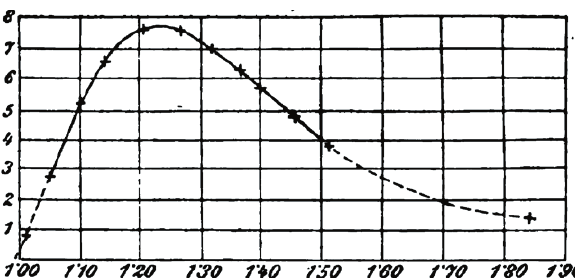
Figure 4. “Relative Leitfähigkeit” (relative conductivity) vs. specific weight (also density) of dilute sulphuric acid. The resistance was measured with alternating current as described in the main text. Abscissa: specific weights of the acid solution at 18.5°C from 1.0504 to 1.5025, corresponding to a content of the acid from 8.3 to 60.3%. The curve depicts the “Leitungsvermögen” at 22°C. From ref. [107] , p.